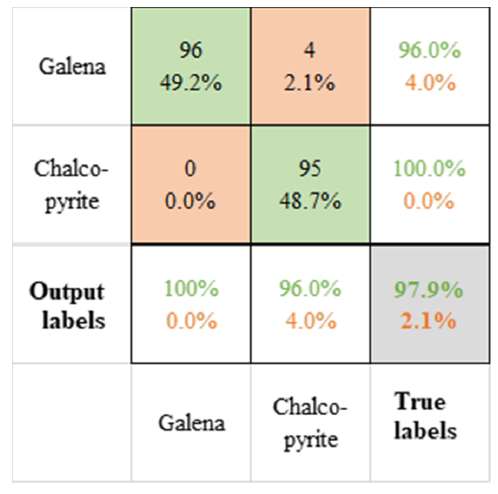
Figure 13. Confusion matrix of the deep learning results for two types of rocks using test data.